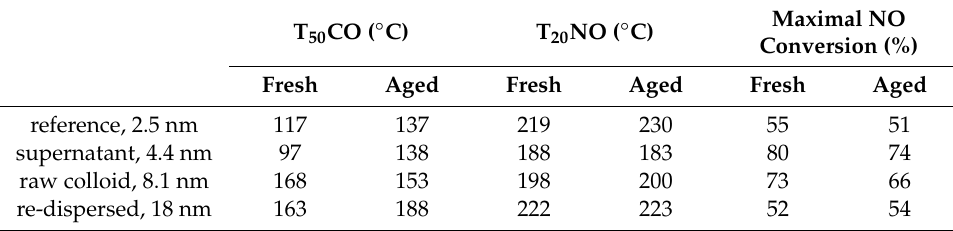
Figure 5. ( A ) Size distribution of the alumina-supported PtPd NPs, where the bars are the result of transmission electron microscope (TEM) image analysis, and solid lines are the resulting log-normal fits; temperature-dependent ( B ) CO and ( C ) NO oxidation of the different PtPd catalysts. Solid lines present the first conversion run, the dashed lines are the conversion after hydrothermal aging, and the horizontal, black dotted-dashed line are the conversion at 50% and 20%, respectively. In B , the conversion rate change after aging is marked by two arrows, where the trend indicated by the solid arrow is valid for all curves, and the trend marked by the dotted arrow is only found for the small-sized catalysts. Table 1. Comparison of the T 50 CO and T 20 NO for the fresh and aged